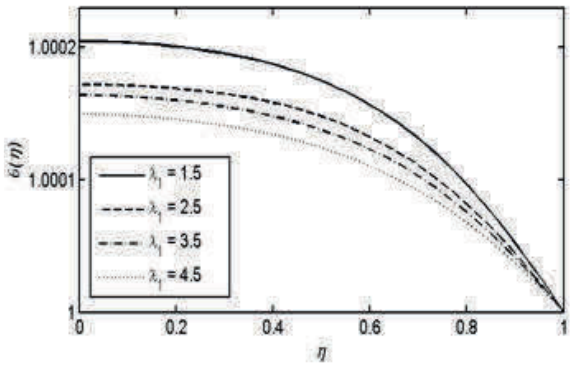
Fig. 10: Variation of non-dimensional temperature with η for differ- ent values of λ 1 for M = 0.5, Pr = 15 and λ 2 = 0.5.